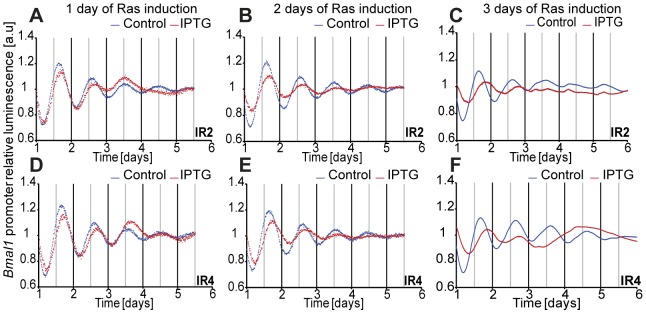
Induction of Ras expression in rat fibroblasts.IR2 and IR4 rat fibroblasts (1×105 cells) were plated in 35 mm dishes 24 hours previous to measurement, and treated with either 20 mM IPTG for Ras induction (red line), or with sterile H2O (blue line) immediately after synchronization with dexamethasone (A) for IR2 and (D) for IR4, or for 48 hours previous to real-time rhythmicity measurement (B) for IR2 and (E) for IR4. 0.5×105 IR2 (C) and IR4 (F) cells were plated in 35 mm dishes and treated with either 20 mM IPTG for Ras induction (red line), or with sterile H2O (blue line) for 72 hours previous to synchronization and bioluminescence was monitored for several days (A and B: 6 counts/h in LumiCycle; C: 12 counts/h in TopCount). Shown are representative detrended data from three independent experiments.